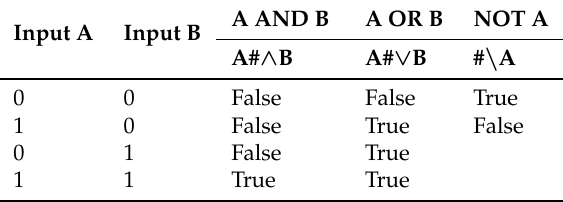
Table 2. Truth table of the AND gate, OR gate, and NOT gate. Note: # indicates a Prolog notation.